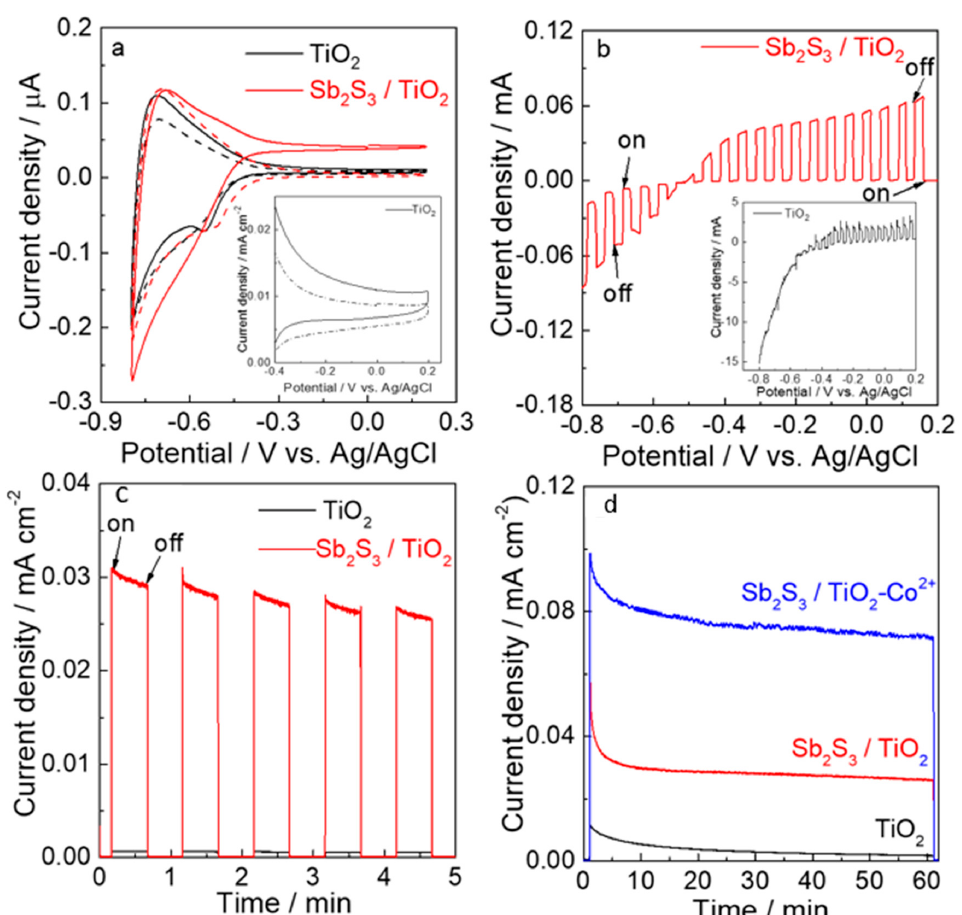
Figure 6. ( a ) CVs measured in the dark (dash) and on irradiation (solid); the subfigures in Figure 6a is the magnification from -0.4 V to 0.2 V for TiO 2 .( b ) LSV plots and; ( c ) Transient on/off chopped photo-current response of the Sb 2 S 3 /TiO 2 (red) and TiO 2 (the subfigures in Figure 6b) photo-anode in a 0.1 M phosphate buffer solution of pH 7.0 with visible light irradiation ( λ > 500 nm, 100 mW/cm 2 ) chopped. ( d ) photo-current density-time profiles for Sb 2 S 3 /TiO 2 (red) and TiO 2 photo-anode (black) in 0.1 m phosphate buffer solution of pH 6.0 during photo-electrocatalytic water oxidation at − 0.3 V vs. Ag/AgCl. Sb 2 S 3 /TiO 2 (blue) in the presence of 0.1 mm Co 2+ ions in the electrolyte